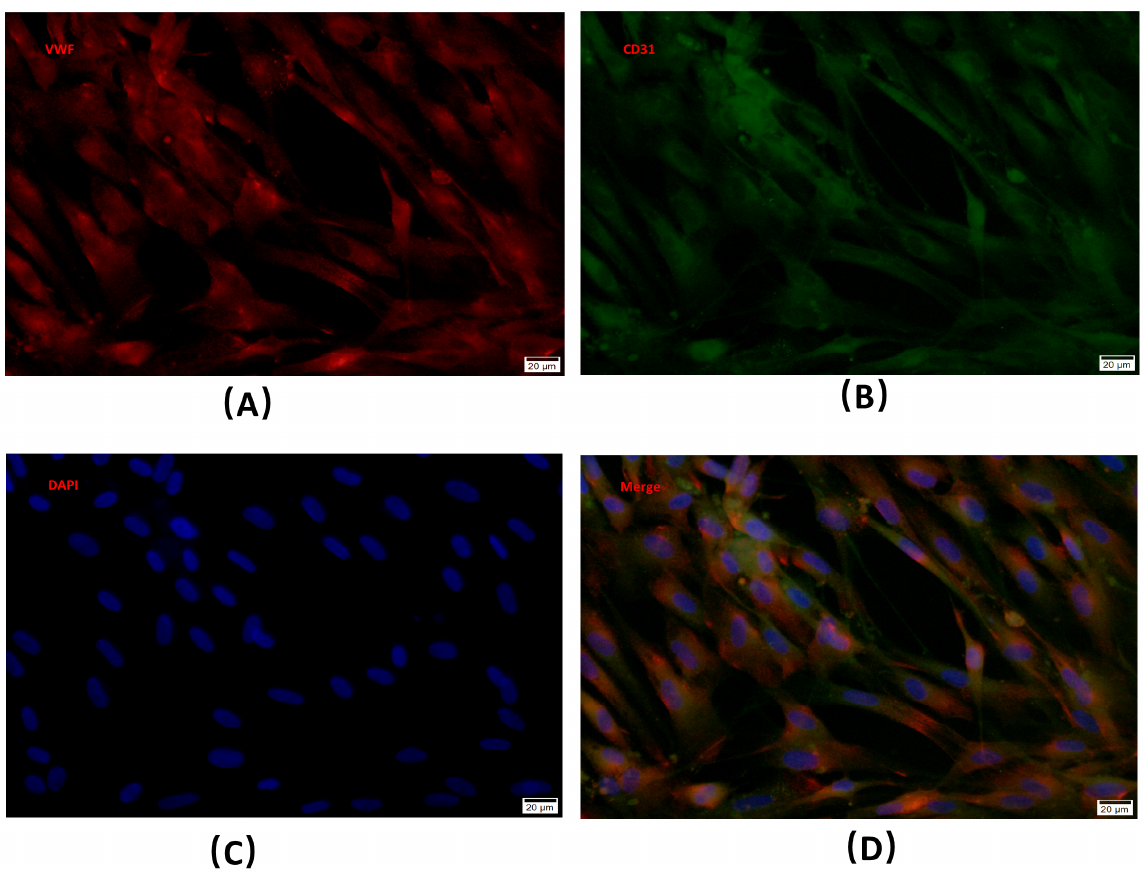
Figure 1. ( A – D ) Identification of microvascular endothelial cells. BMECs-specific markers were detected via immunofluorescence staining.